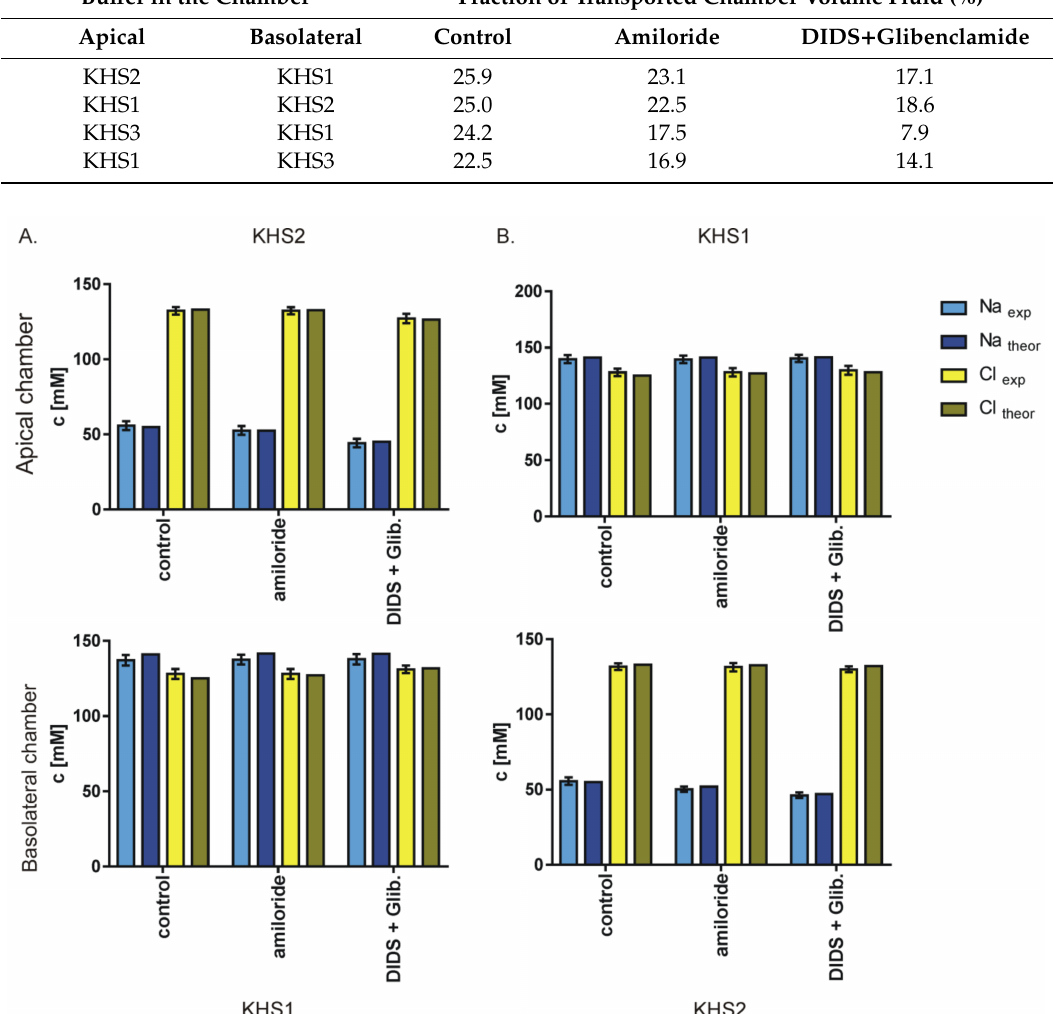
Figure 7. Measured (Mean ± SD) and theoretically predicted concentrations of sodium and chloride ions on both sides of the cell layer in control conditions after blocking particular ion channels present on the apical side of the monolayer. The experiments with sodium gradients and isosmotic flow of x fraction of 145 mM sodium chloride across the epithelial cell monolayer are